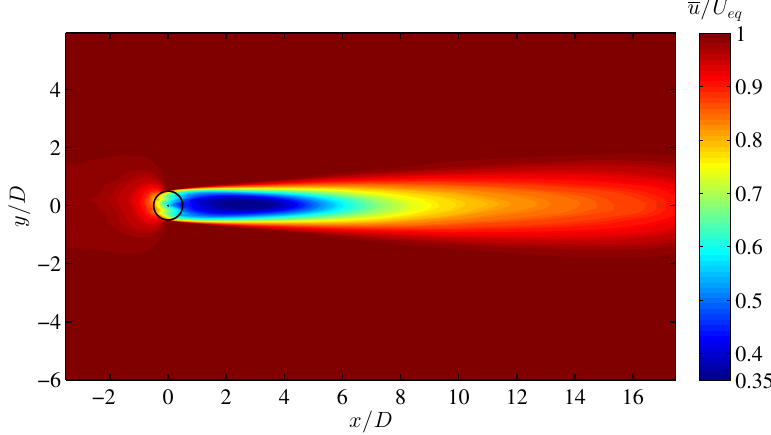
Figure 6. Contours of the normalized mean streamwise velocity ( u / U eq ) in the x - y plane at the equator height of the turbine.